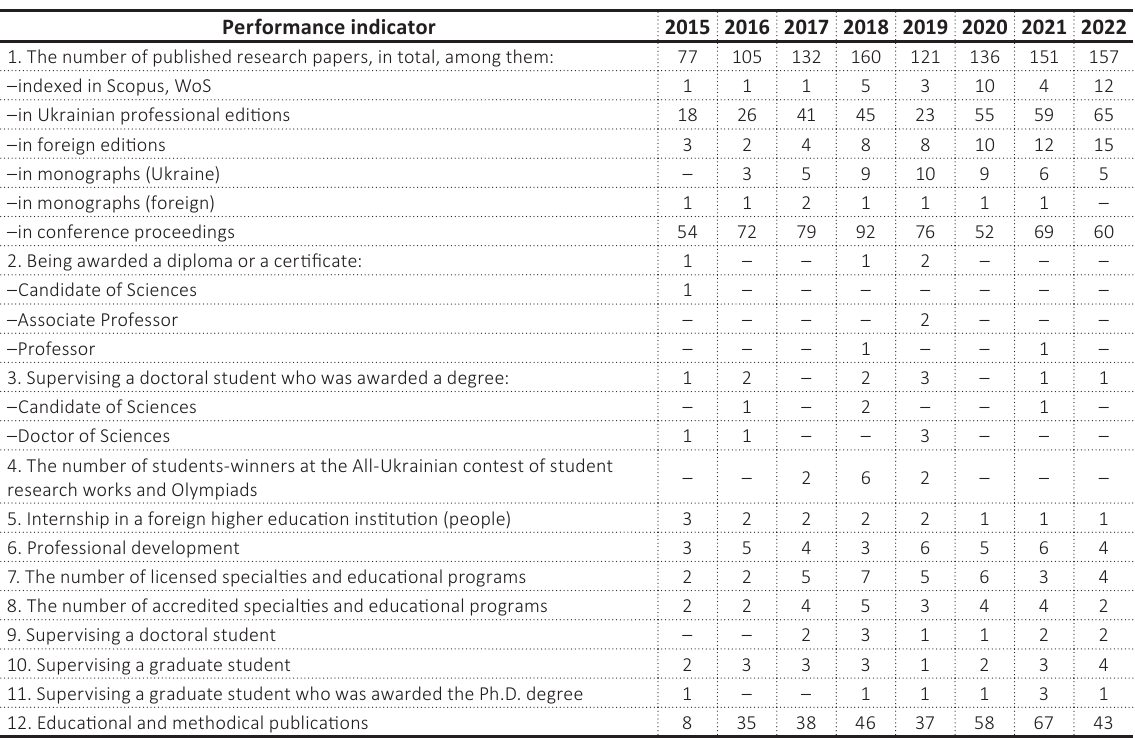
Table 1. Performance of 20 former economy teachers of Donetsk National Technical University throughout their employment at other Ukrainian and foreign universities in 2015–2022